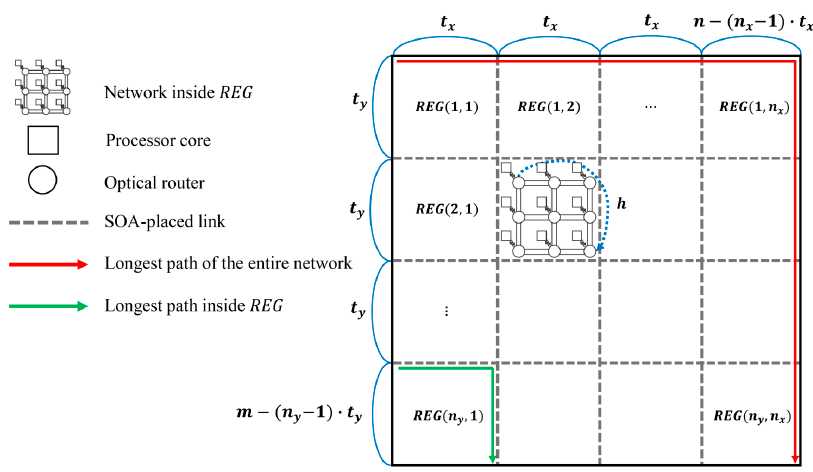
Figure 7. Non-SOA sub regions ( 𝑅𝐸𝐺 ) according to the SOA placement algorithm.